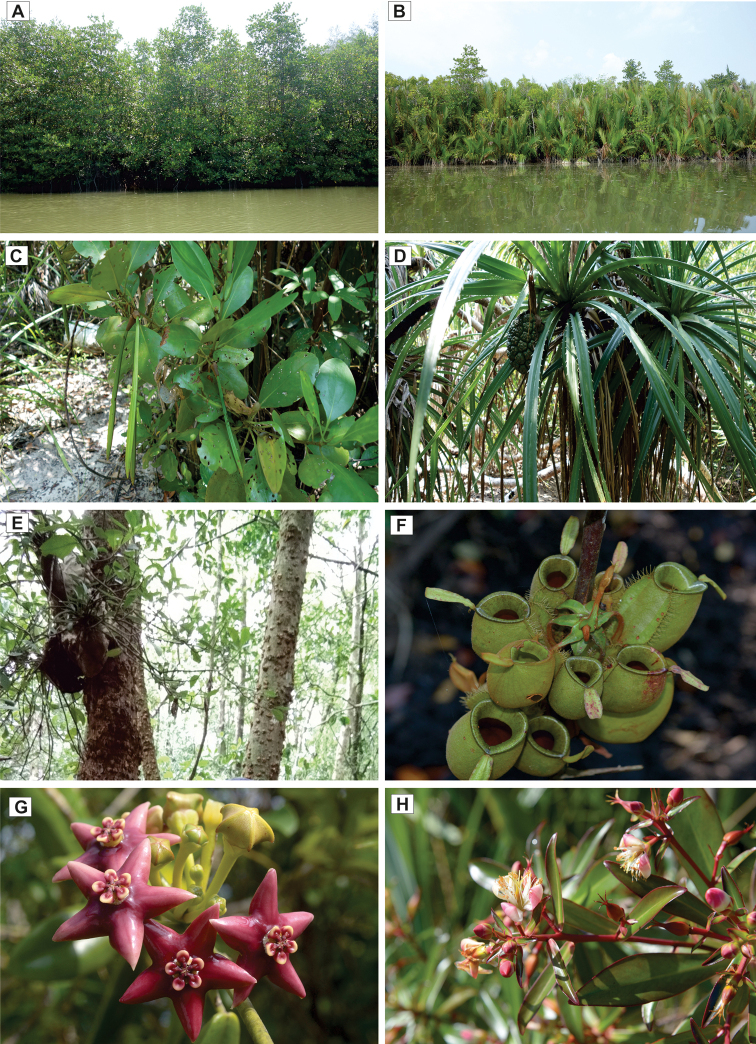
Different plant communities in Setiu Wetlands. A Mangrove plants B Nipa palm (Nypa
fruticans) population CCeriops
zippelianaDPandanus
tectoriusE Ant plant, Hydnophytum
formicarum attached to Bruguiera
hainesiiFNepenthes
ampullariaGHoya
coronariaHPloiarium
alternifolia.